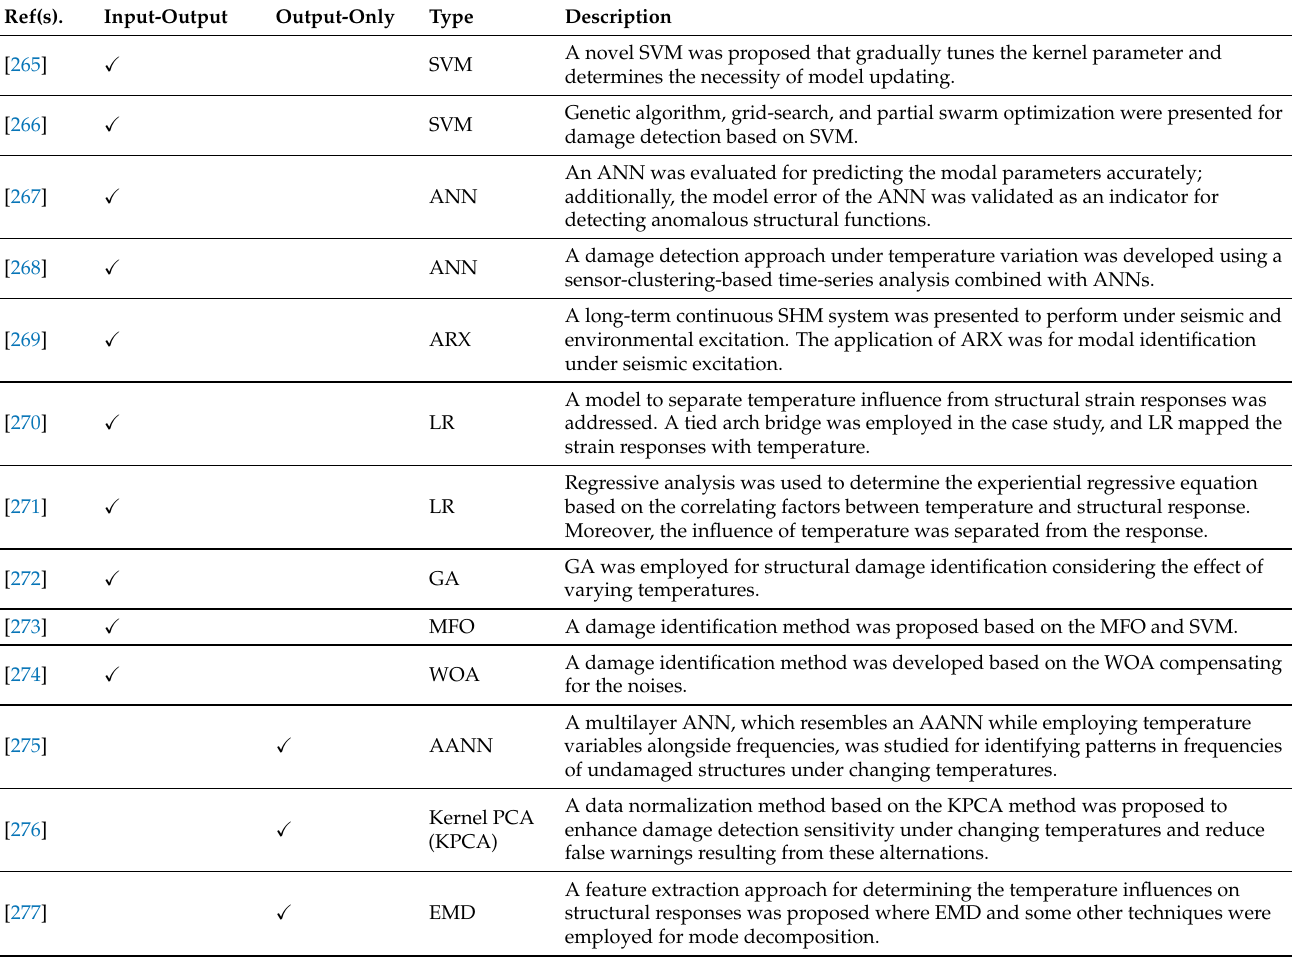
Table 5. Recent papers on data analysis algorithms considering temperature variations.